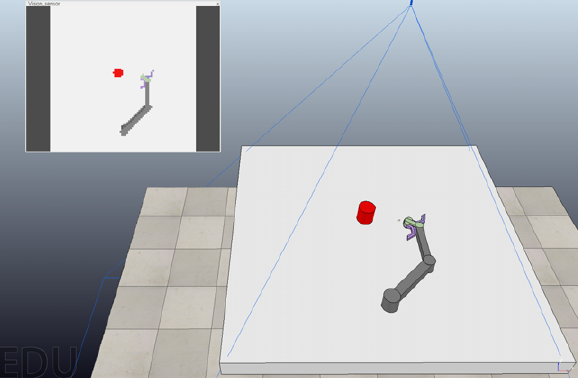
Figure 4: The V-REP robotic environment used in the first experiment including the 3-DoF arm with a gripper attached and a red cylin- drical target. The vision sensor output is shown in the upper left corner.